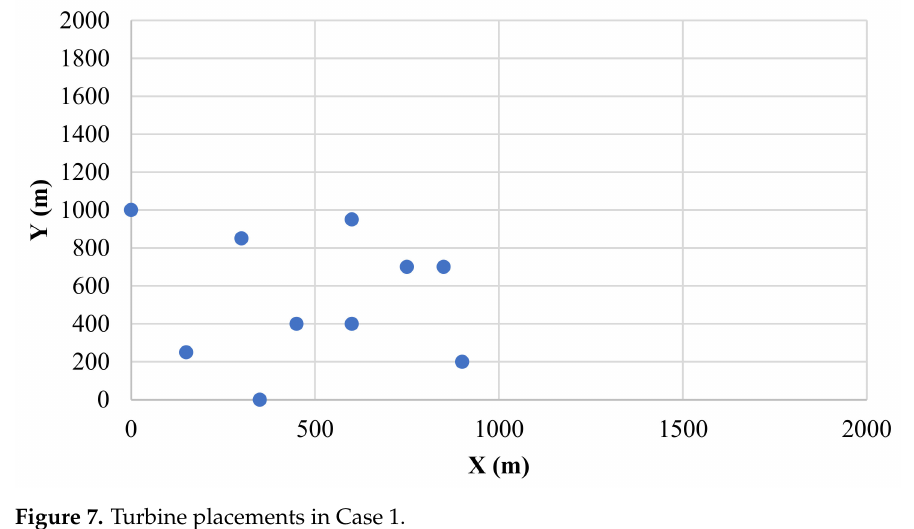
Figure 7. Turbine placements in Case 1.